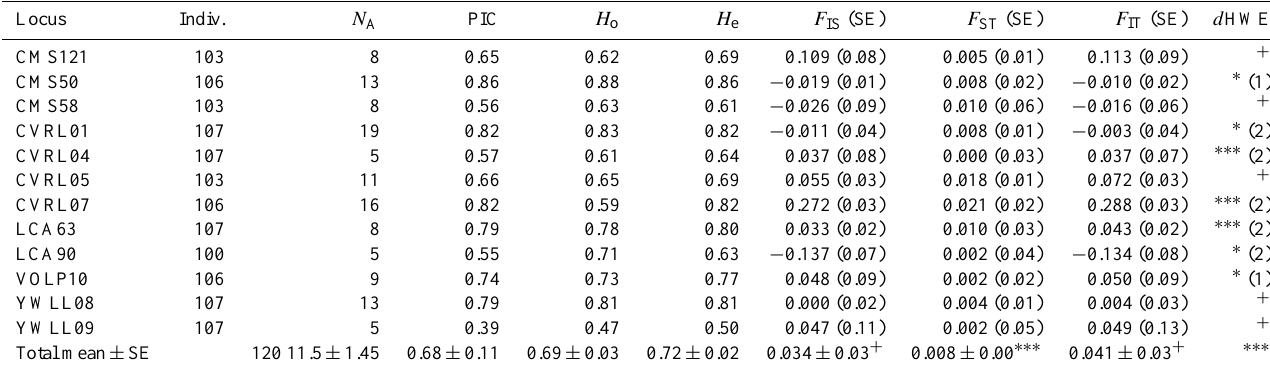
Table 2. Genetic diversity parameters and mean values of microsatellite marker loci. Locus Indiv.